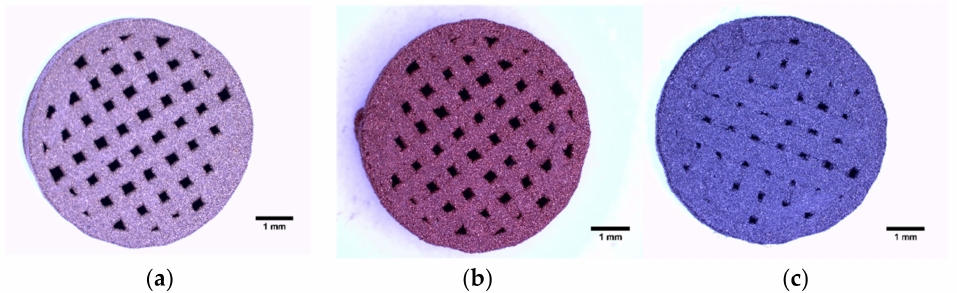
Figure 2. Disk-shaped 3D printed samples with line spacing of 0.7 mm of ( a ) bronze-filled PLA, ( b ) copper-filled PLA, ( c ) steel-filled PLA. Scale bars correspond to 1